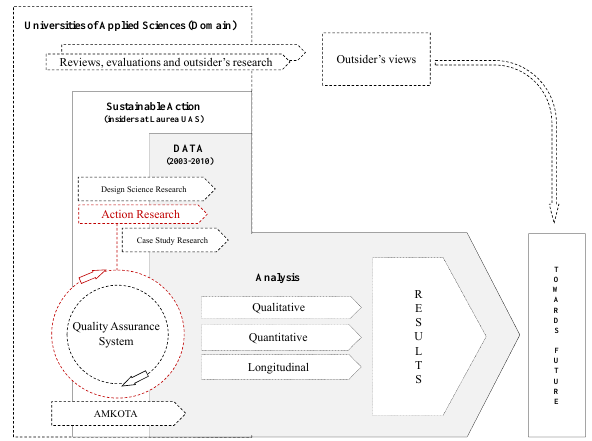
Figure 3. Integrative R&D Framework